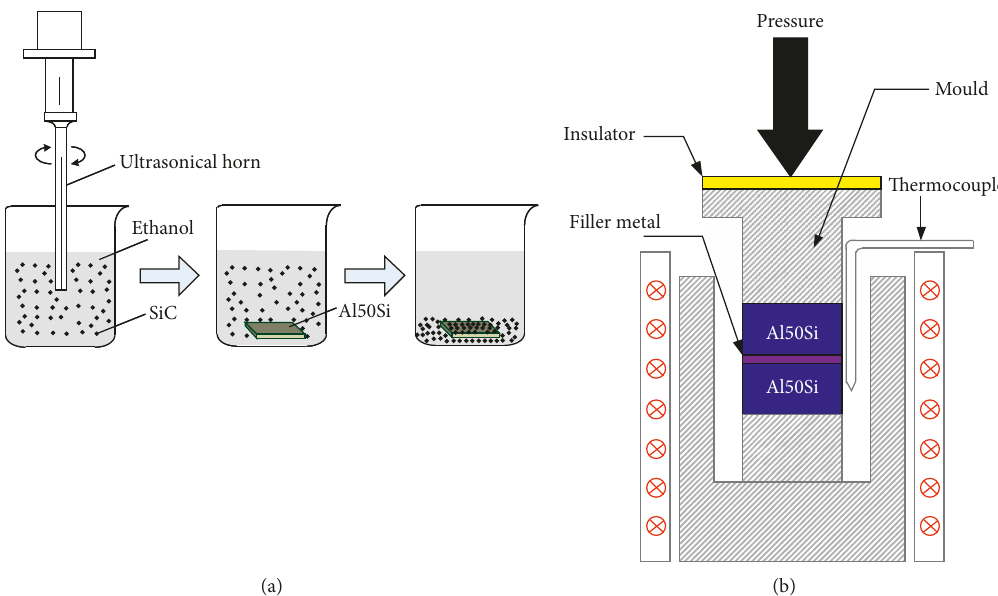
Figure 1: Schematic diagram of (a) suspension sedimentation and (b) semisolid brazing.